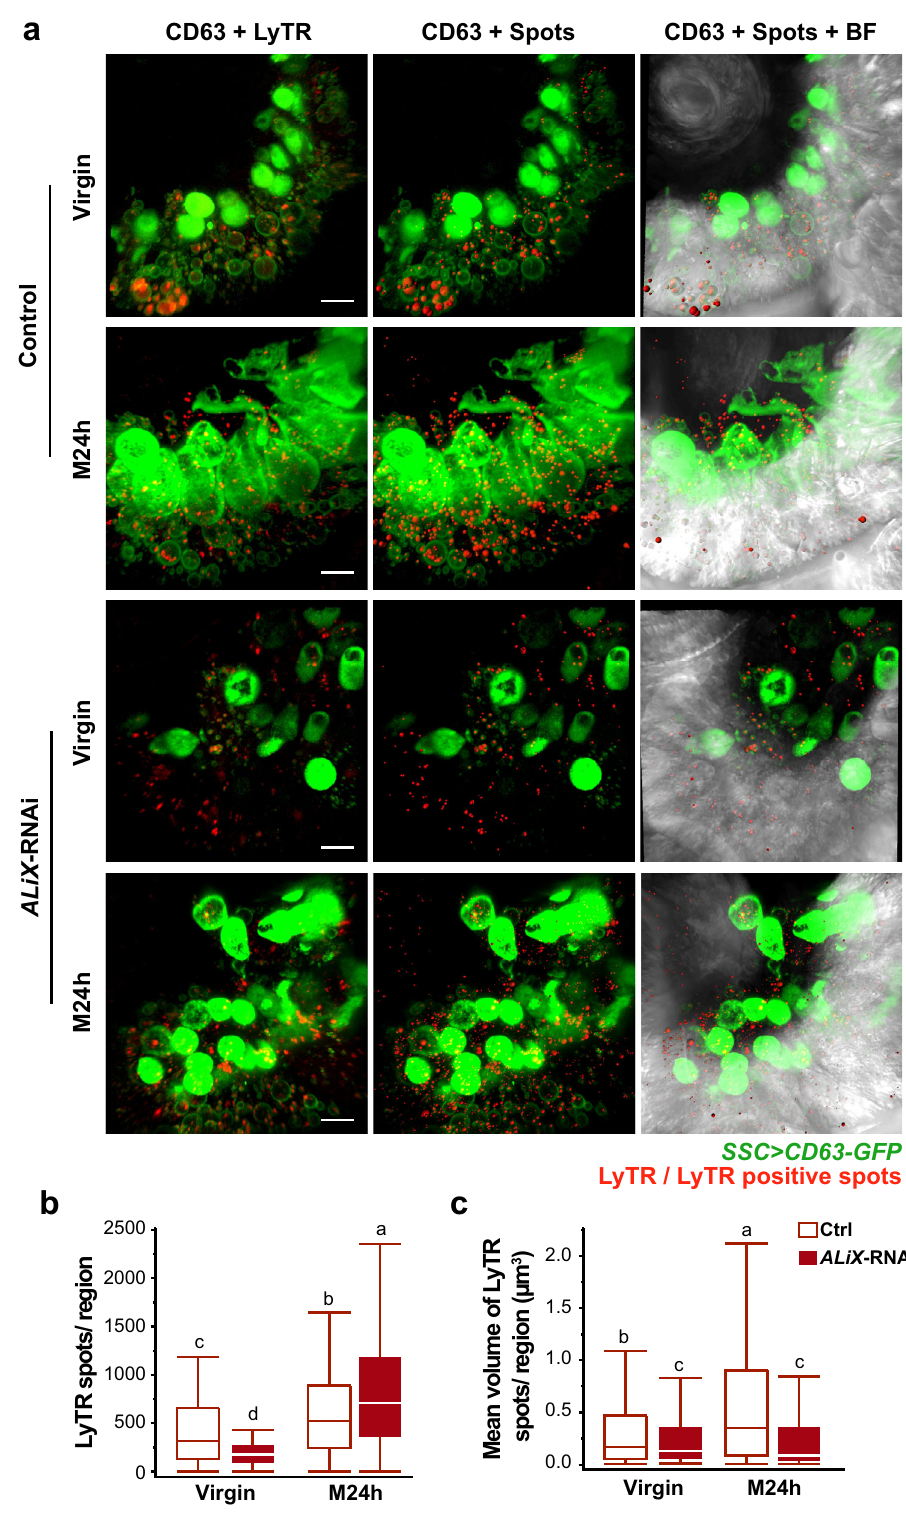
Fig. 7 Silencing ALiX in the SSC changes the pattern, number and size of acidic compartments. a Representative sections of the spermatheca (the type of sampled region is shown in the inset of Fig. 3a) of control (no RNAi) or ALiX -RNAi virgin and mated at 24 h post-mating (M24 h) females. The micrographs depict SSC expressing CD63-GFP stained with LysoTracker Deep Red (LyTR, left), SSC with LyTR spots rendered as plastic surfaces (middle) and rendered LyTR spots overlaid on the bright fi eld (BF) channel (right). The LyTR puncta were analyzed by spot detection in Imaris to estimate ( b ) number of spots per region, and ( c ) mean volume ( µ m 3 ), of control and ALiX -RNAi virgin and mated females at 24 h post-mating. The box plots represent maximum, median and minimum values with outliers of 15 – 20 spermathecae per condition (From 10 – 15 fl ies); letters denote signi fi cant differences (one- way ANOVA, with multiple comparison post-hoc test, p < 0.05) (see also Fig. 3c). Scale bar = 10 µ